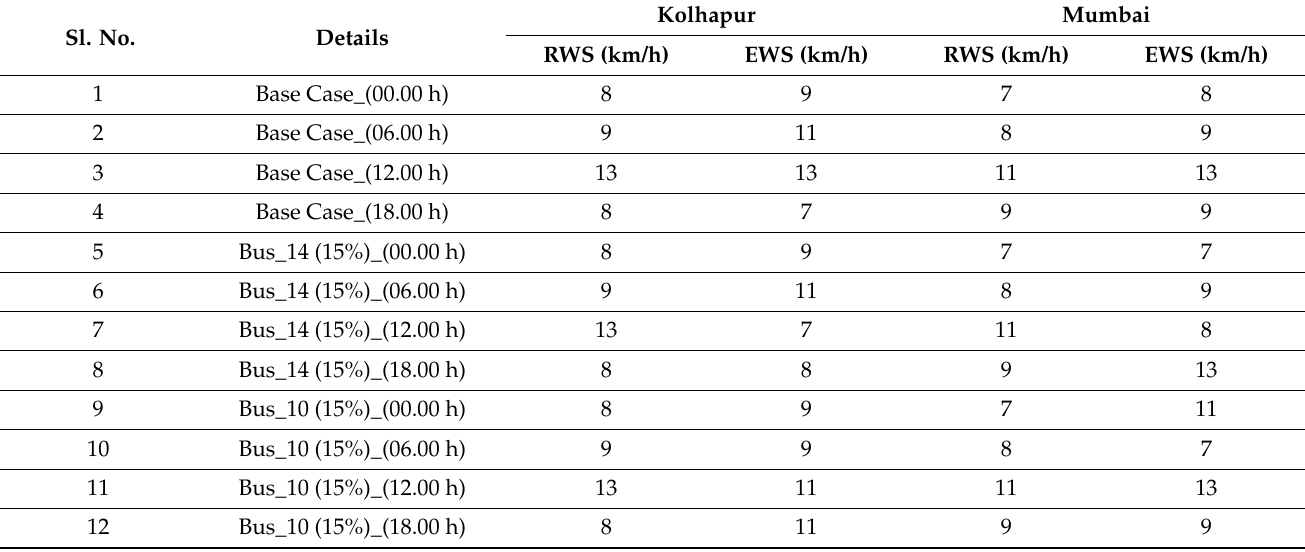
Table 2. Real-time Wind Speed Data [44].